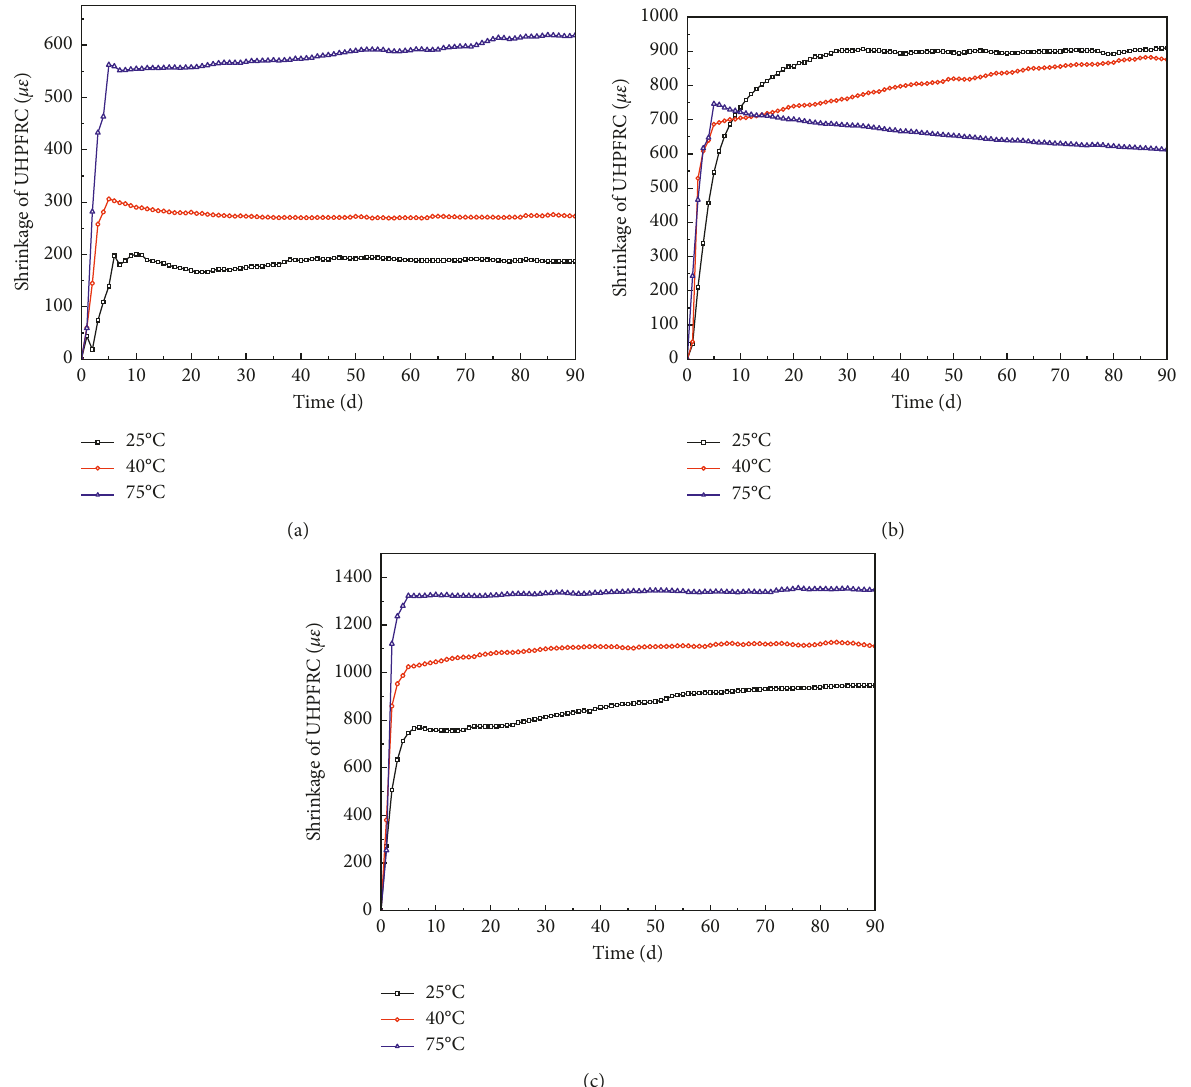
Figure 2: The shrinkage of UHPFRC in 90d. (a) Soaked condition. (b) Sealed condition. (c) Dry